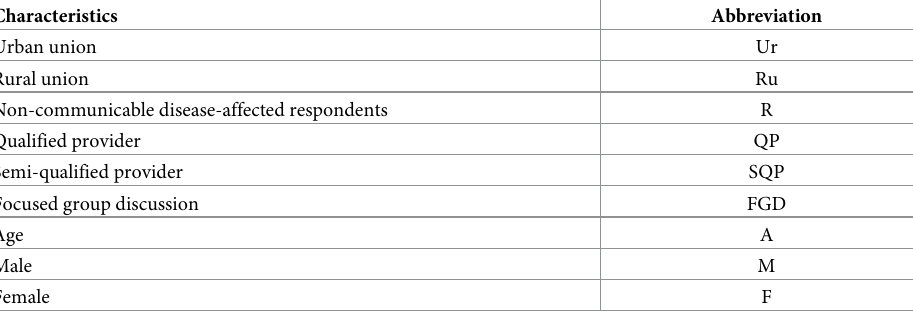
Table 3. Abbreviations for respondent